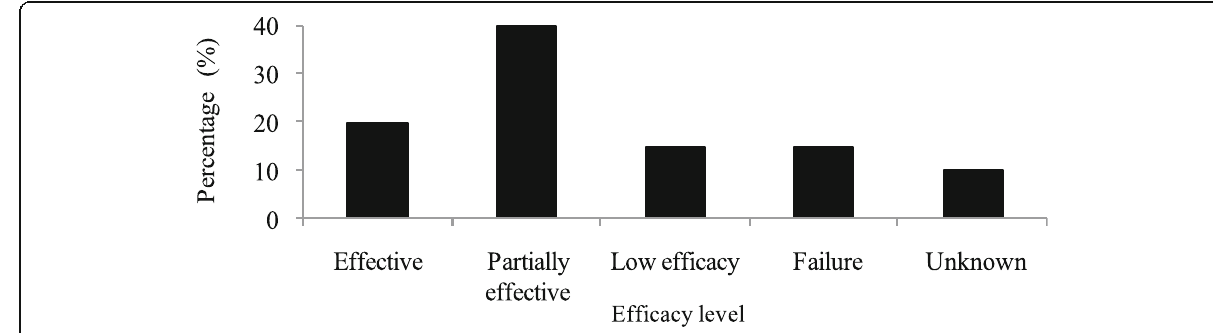
Fig. 7 Efficacy level of introduced species used in term of classical biological control only in Moroccan citrus orchard ( N =